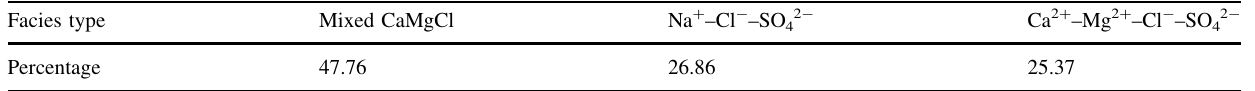
Table 5 Hydrochemical facies of groundwater samples into different water types in the study